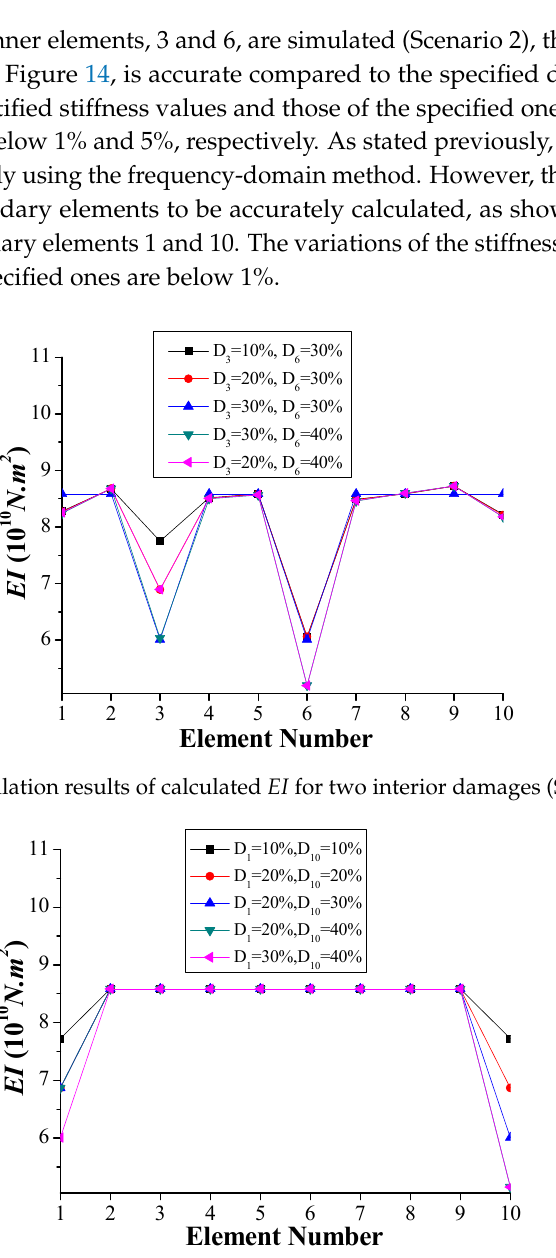
Figure 15. Simulation results of calculated EI for boundary damages (Scenario 3).